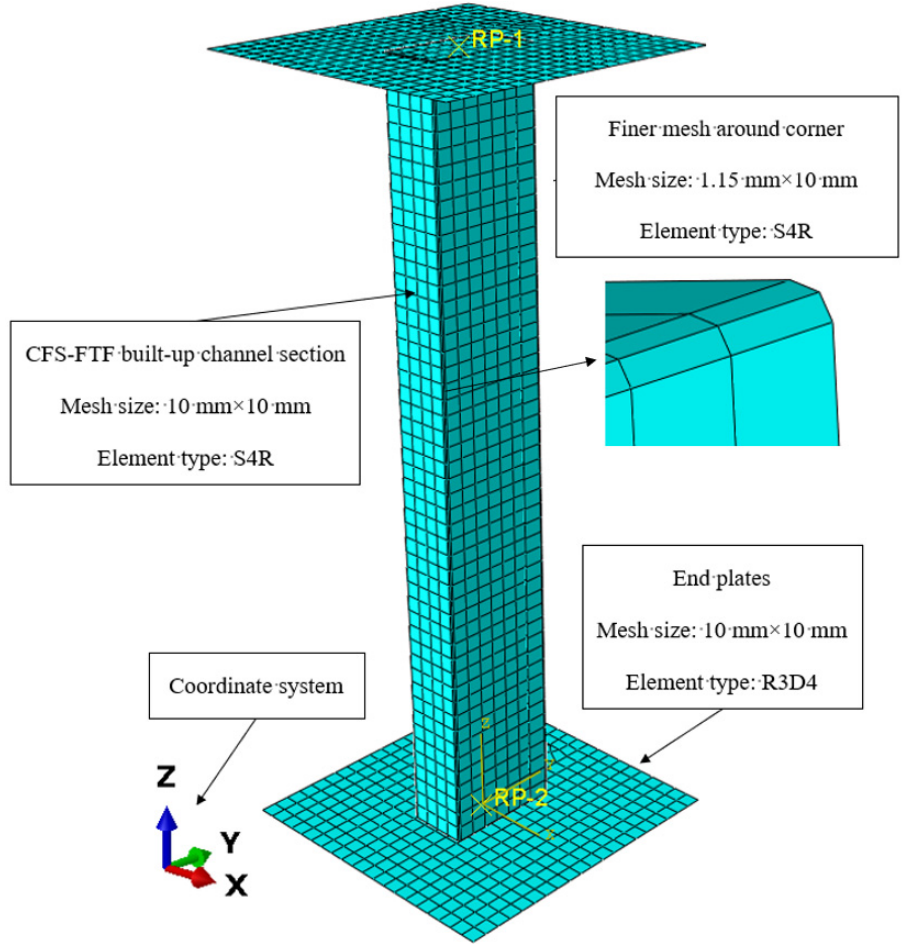
Figure 2. Meshing details used in FE models.